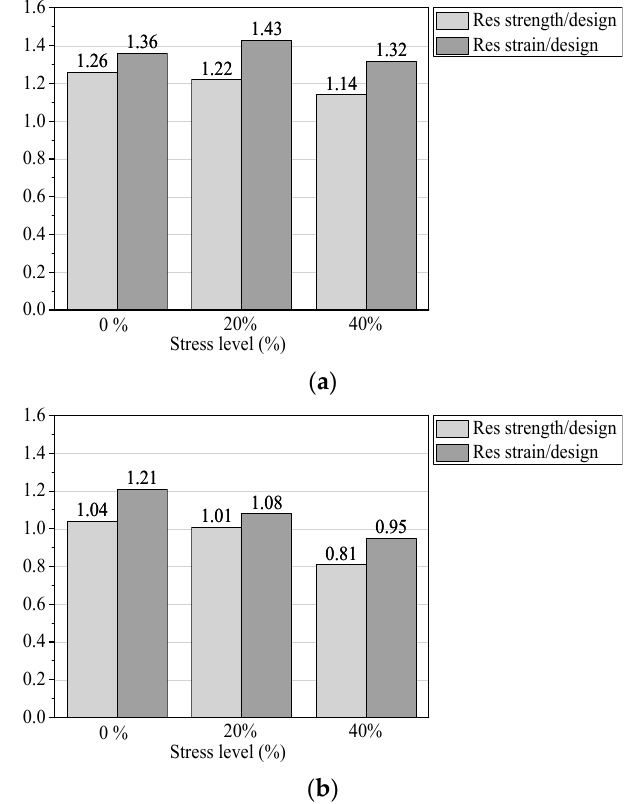
Figure 9. Ratios between the residual tensile strength / strain of conditioned GFRP bars and design limits specified by ACI 440.1R-15 ( a ) Exposure to seawater solutions and ( b ) exposure to concrete pore solutions.